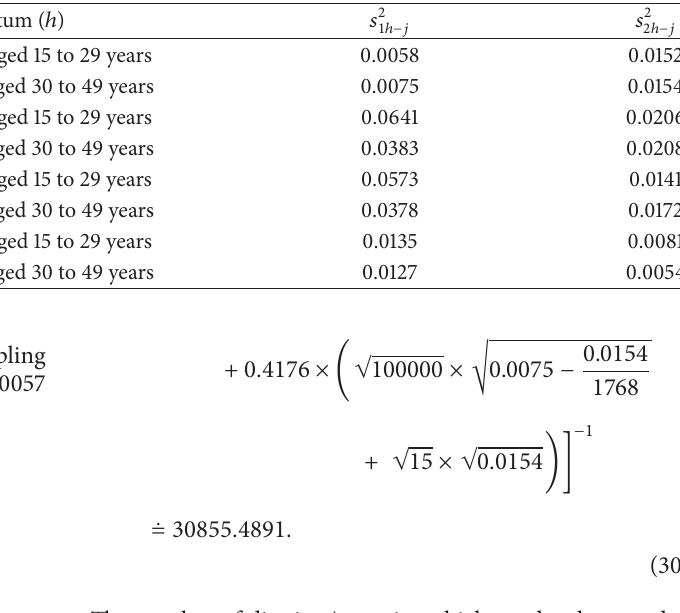
Table 1: Variances necessary for sample size formulae.